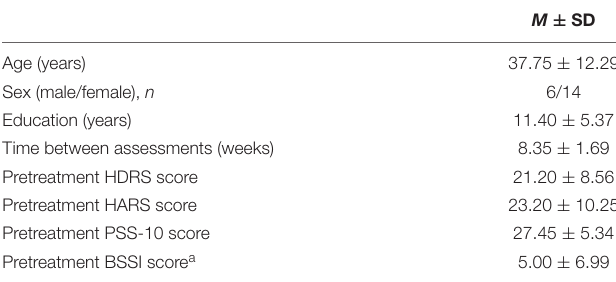
TABLE 1 | Demographic and clinical characterization of all patients ( N = 20) included in the data